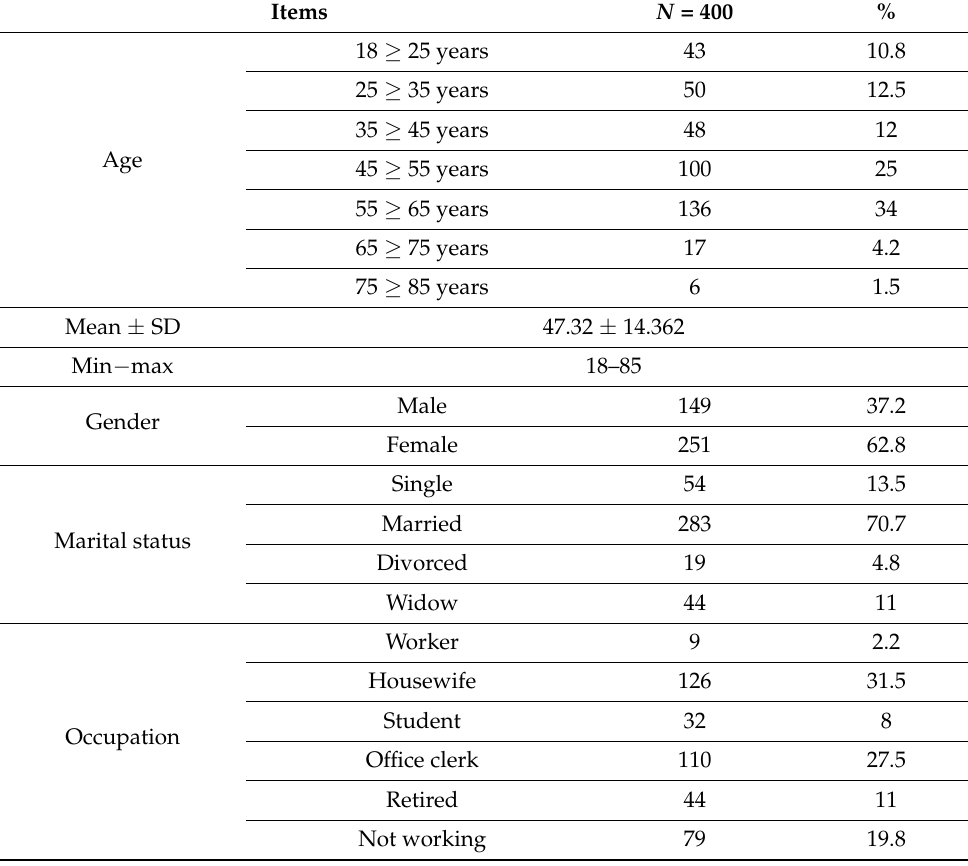
Table 1. Sociodemographic characteristics for patients in the study. Items N = 400